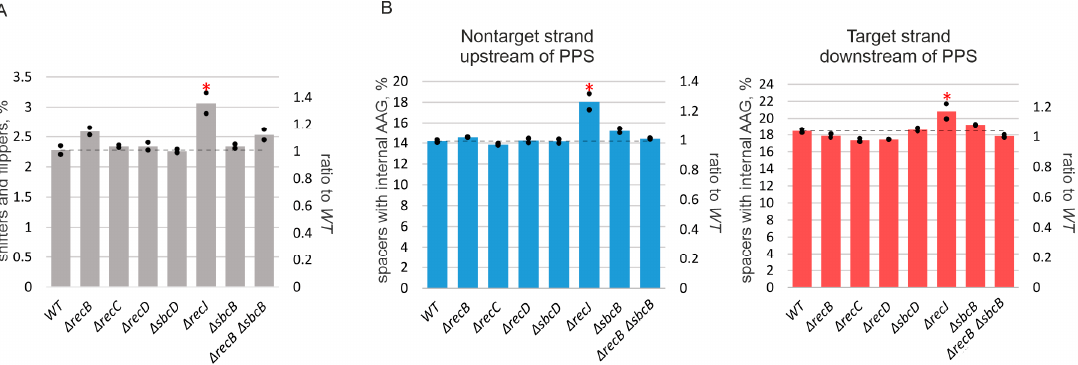
Figure 4. RecJ a ff ects spacer acquisition precision and specificity. Spacers acquired by indicated cells were mapped to an area within 200 kbp upstream and downstream of the PPS for KD403 and indicated derivatives. ( A ) Percentage of inaccurately incorporated spacers (both shifters and flippers [38]) in indicated cultures. The numbers on the right axis show the ratios of inaccurately incorporated spacers to those obtained for WT cells. ( B ) Percentage of spacers with internal AAG trinucleotides. Data for spacers mapping to nontarget strand upstream of the PPS and target strand downstream are shown by blue and red bars, correspondingly. The heights of bars show mean values obtained in two independent experiments (black dots show values obtained in each individual experiment). The numbers on the right axis show the ratios of spacers with internal AAG trinucleotides to those obtained for WT cells. The dotted line shows the average level for the parental KD403 (“WT”) strain. Red asterisks mark values that significantly differ from the WT level according to pairwise proportional test with a p -value of 0.001.